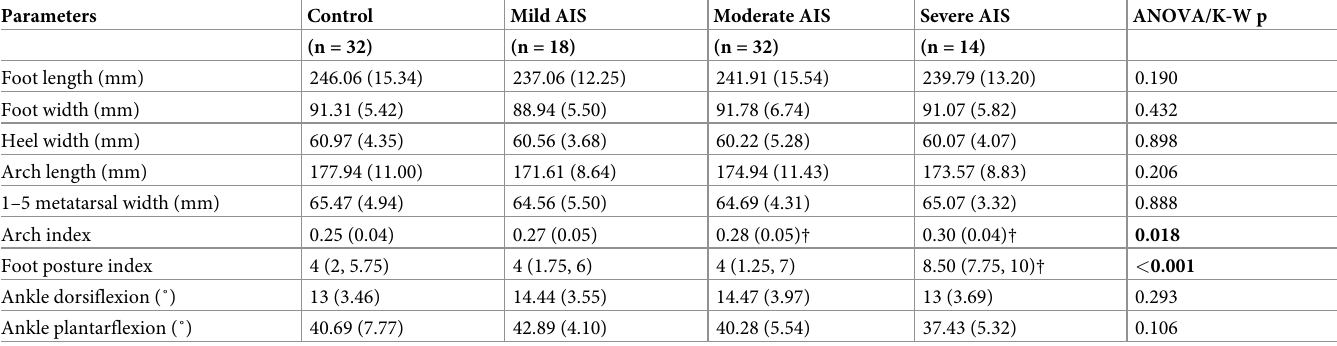
Abbreviations: AIS, adolescent idiopathic scoliosis; ANOVA, one-way analysis of variance; K-W, Kruskal-Wallis rank test. † Significant difference compared to the control group (P < 0.05).